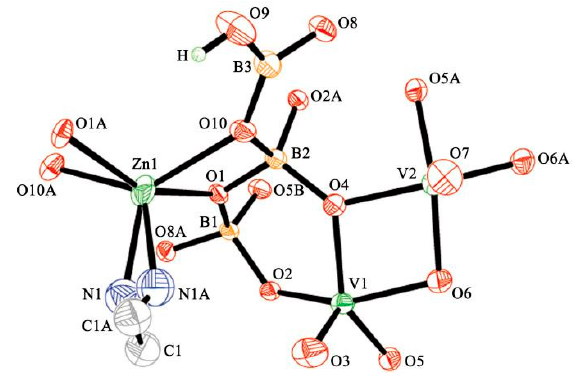
Figure 2. An asymmetric unit of compound 1 .